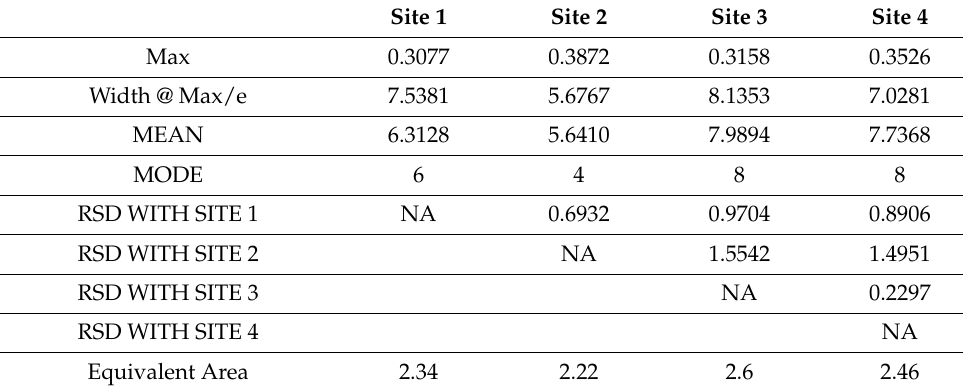
Table 6. Quality of the number of crossings at 1/12 max power as a classifier.